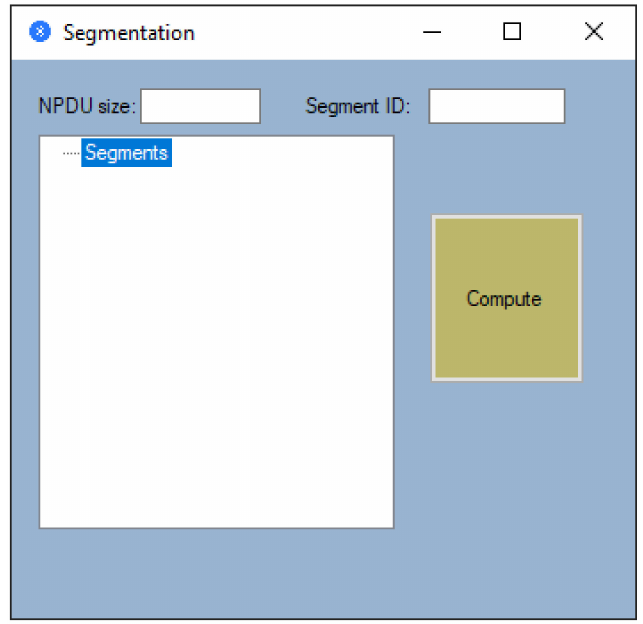
Figure 8. Segmentation window.